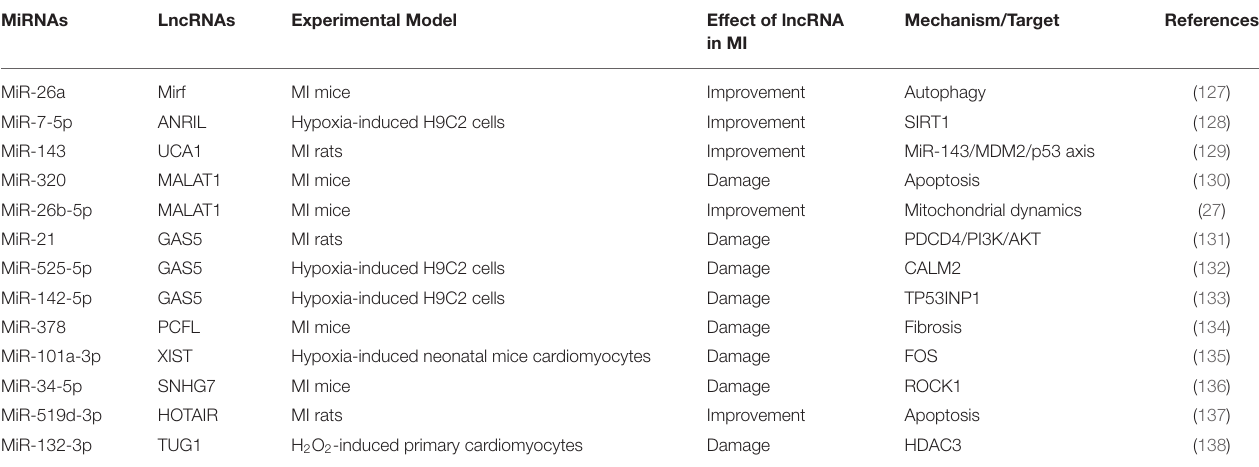
TABLE 7 | Summary of studies on lncRNAs as sponges of miRNA during MI in the past 5 years.